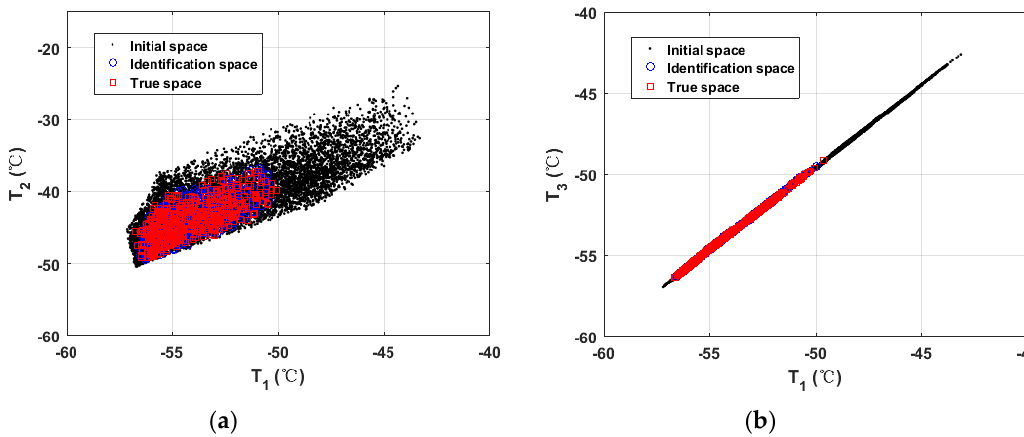
Figure 10. The initial, true, and identification space in the heat transfer system: ( a ) Temperature response T 1 –T 2 ; ( b ) Temperature response T 1 –T 3 .